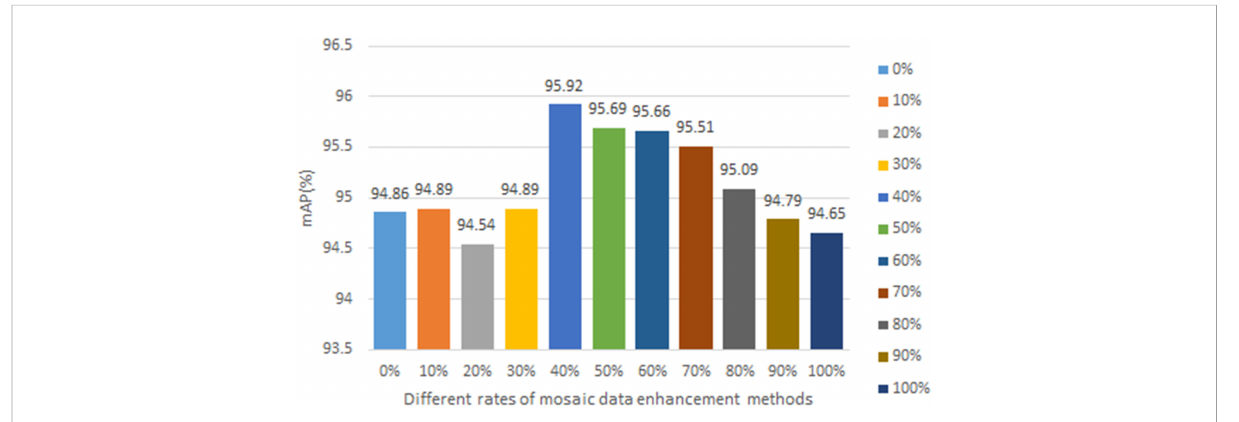
FIGURE 1 Different rates of mosaic data enhancement